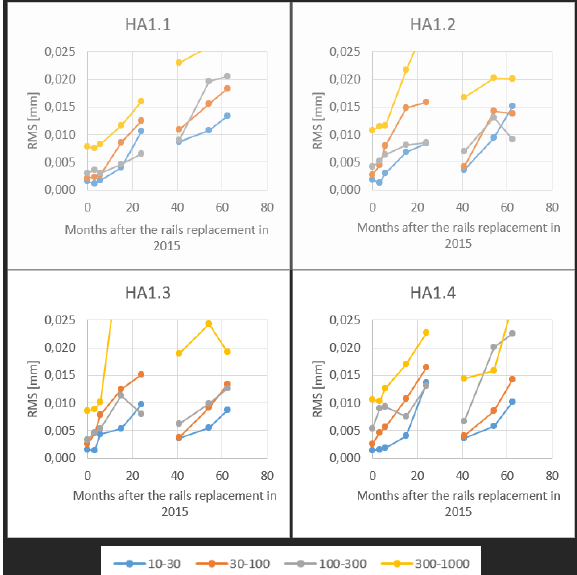
Figure 2. RMS progression in time for section Hady.